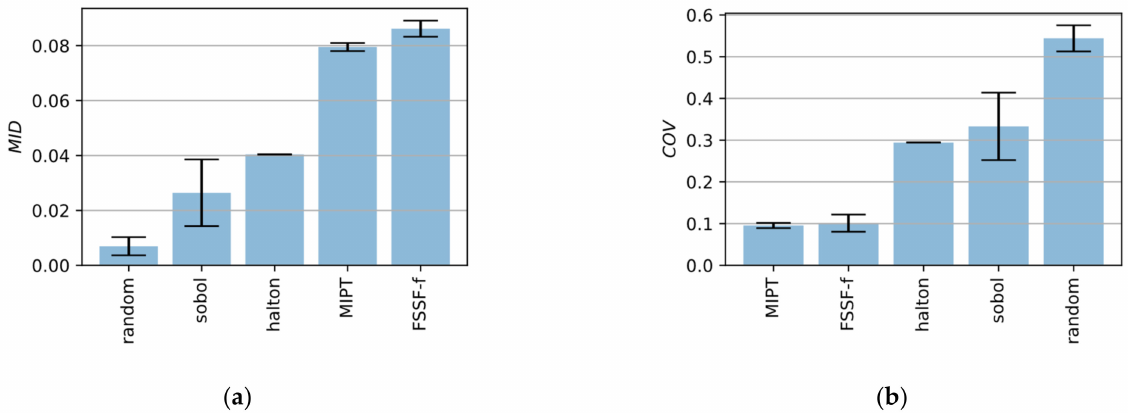
Figure 7. Benchmark of different sequential space-filling methods for 2-dimensional space. Blue bars show the mean value of 10 different designs. Black whiskers show the minimum and maximum values. ( a ) minimum intersite distance; ( b ) cover measure.